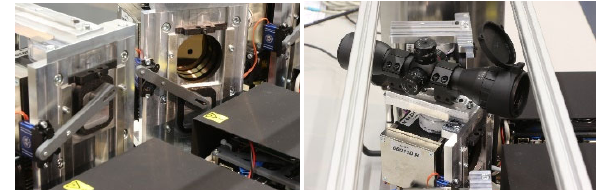
Figure 7. left: two distance meters with one closed and one opened retractable shutter for the reference distance data; right: telescopic sight for alignment to the measurement object To align the laser beams in a plane, they must represent a line when intersecting with a plane in object space. An adjustment of the laser beams is done by two different recording distances to detect a possible vertical axis error.